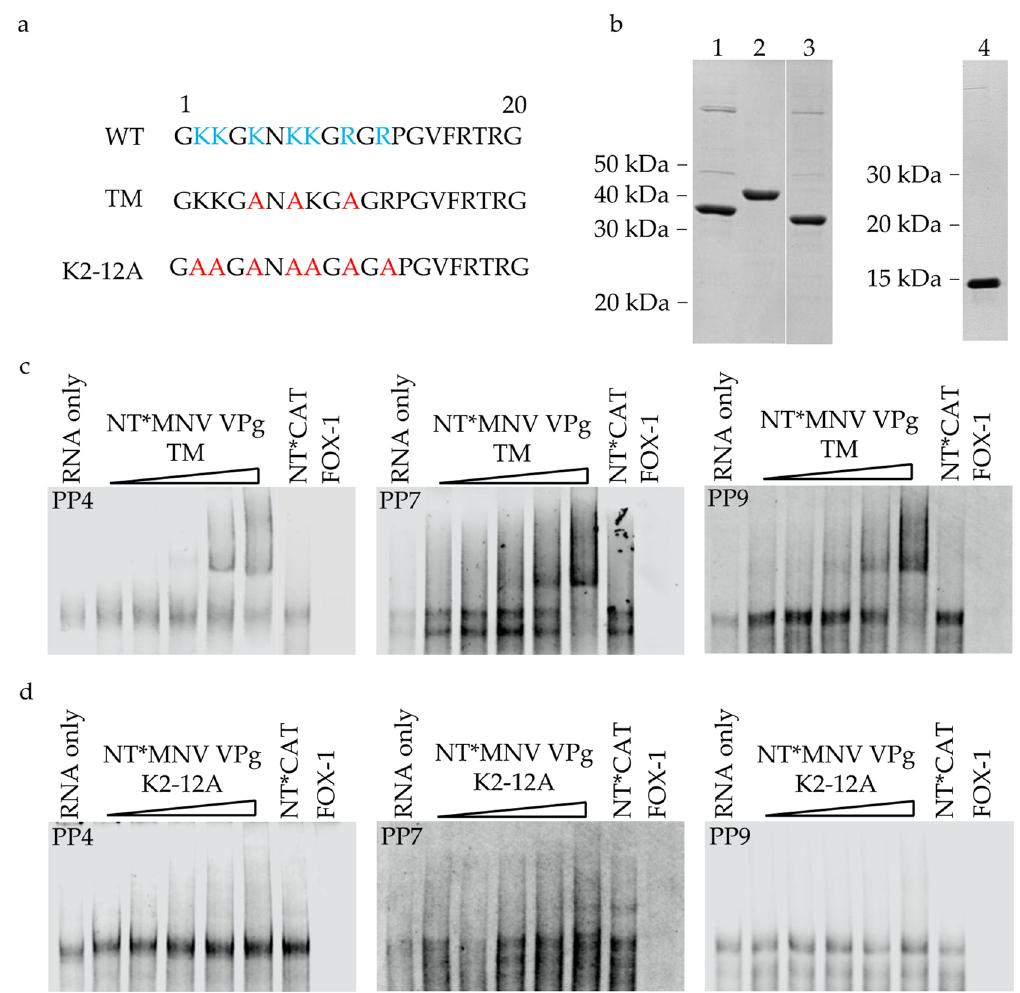
Figure 8. N-terminal lysine and arginine amino acids are important for binding to RNA. ( a ) Schematic of the first 20 amino acids of MNV VPg, wild-type amino acids are shown in blue. Amino acids mutated to alanine are shown in red for the NT*MNV VPg and NT*MNV VPg K2-12 constructs, respectively. ( b ) Coomassie blue stained SDS-PAGE gel of purified protein (3 µ g) used for RNA binding experiments. 1; NT*MNV VPg TM; NT*CAT, 3; NT* MNV VPg K2-12 and 4; FOX-1. ( c , d ) RNA EMSA of NT*MNV VPg K2-12 and NT*MNV VPg TM with pentaprobe RNA. Proteins were incubated with 100 nM UTP ATTO 680 labelled pentaprobe RNA for 30 min, separated on a 5% TBE gel and directly imaged in the 700 nm channel. The concentration of NT*MNV VPg TM was increased from 0.5 µ M to 8 µ M in 2-fold increments. NT*CAT (8 µ M) was included as a negative control and FOX-1 (8 μ M) as a positive control.